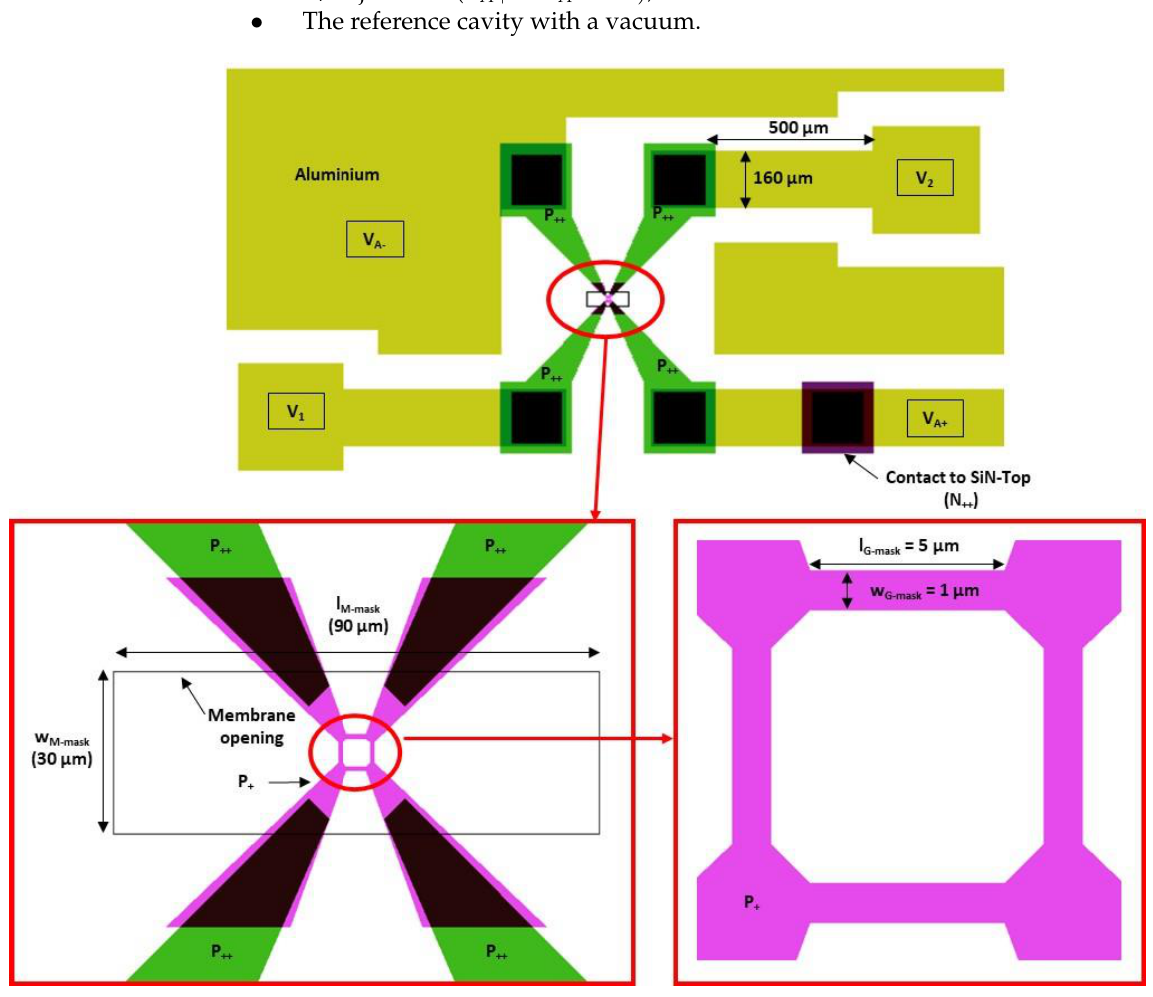
Figure 9. Top view of the mask used in the technological process.